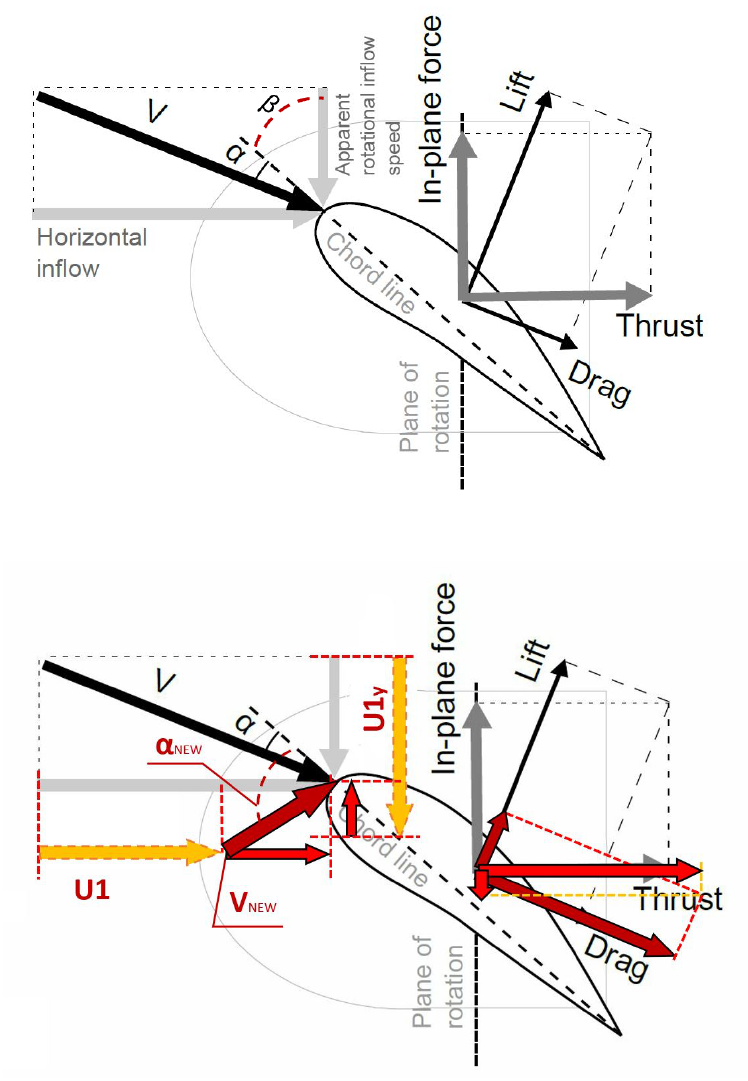
Figure 11. Inflow velocity vectors on blade sections in harsh